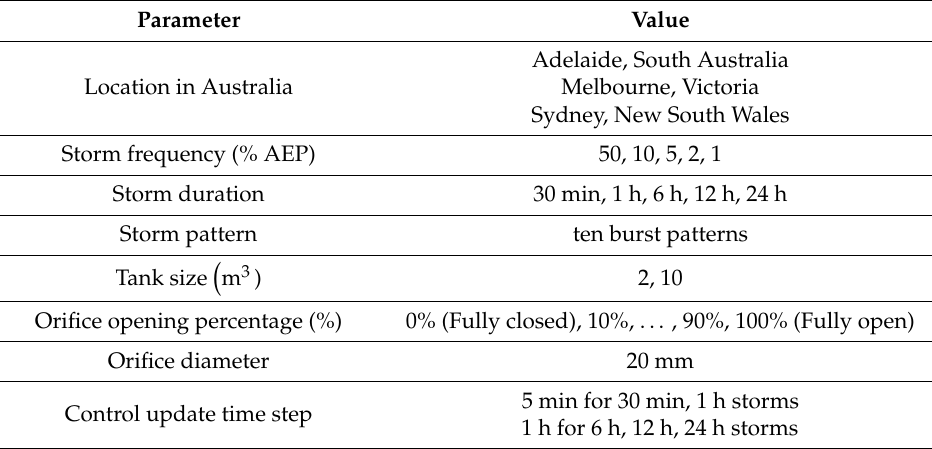
Table 2. Summary of experiment